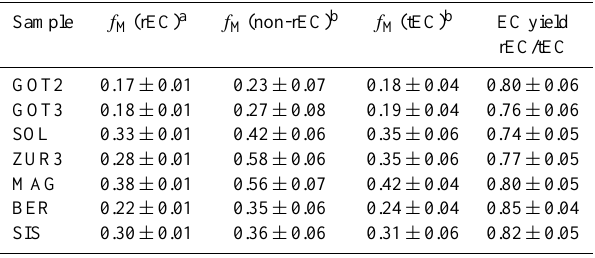
Table 4. EC yield and fraction of modern ( f M ) of the refractory EC (rEC), non-refractory EC (non-rEC) and total EC (tEC).